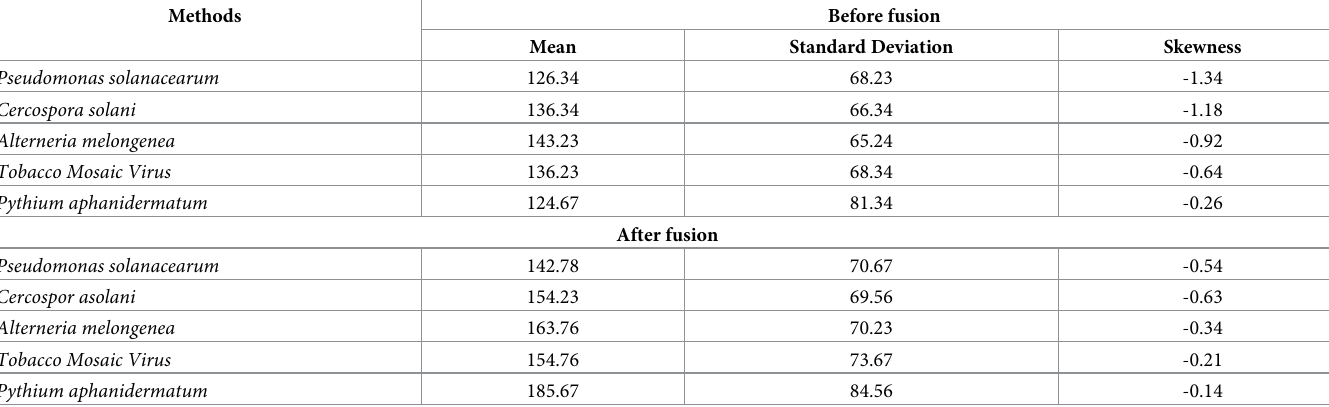
Table 5. Color features of brinjal leaf images before and after fusion using DST.